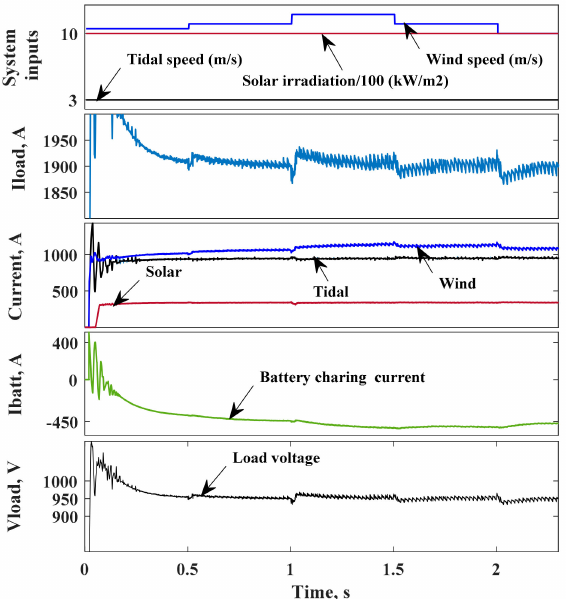
Figure 16. Case-a: performance of a single floating energy unit at the normal operating condition when RES supplying surplus